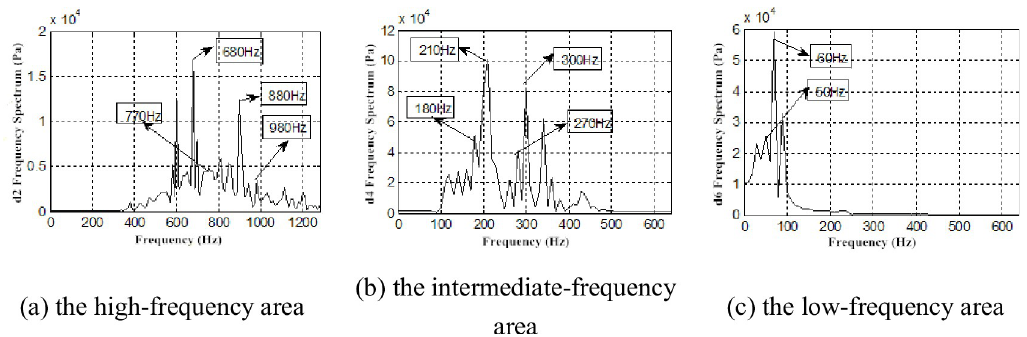
Fig 11. Frequency spectrum of interstage pressure pulsation restructuring signal under F = 0.605.